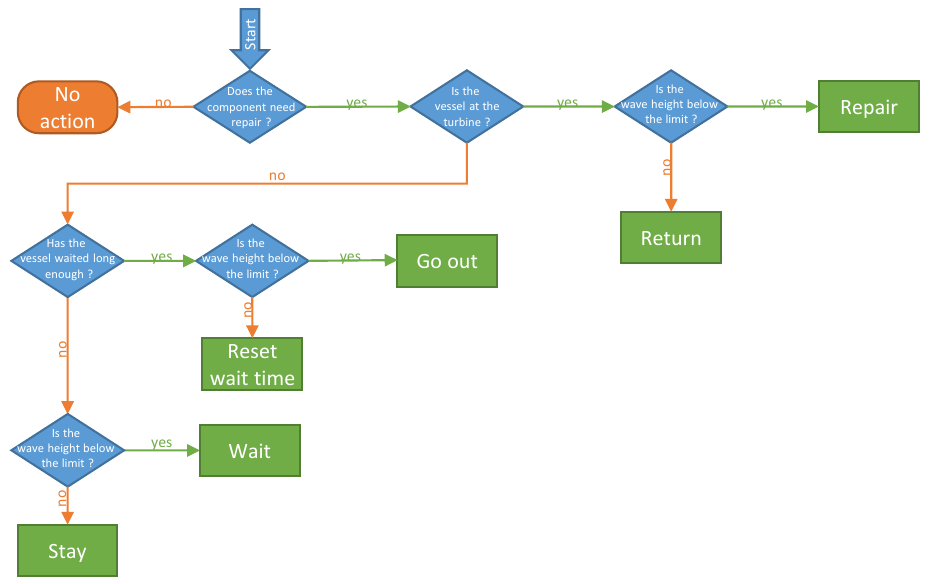
Figure 5. The decision tree for the wait-n-steps policy. First, the decision maker checks, whether a repair is necessary (repair time > 0). Depending on the location (at turbine), a wait-time check is conducted. This depends on the number of wait steps specified by the policy (1 h, 2 h, 3 h). Finally, the weather